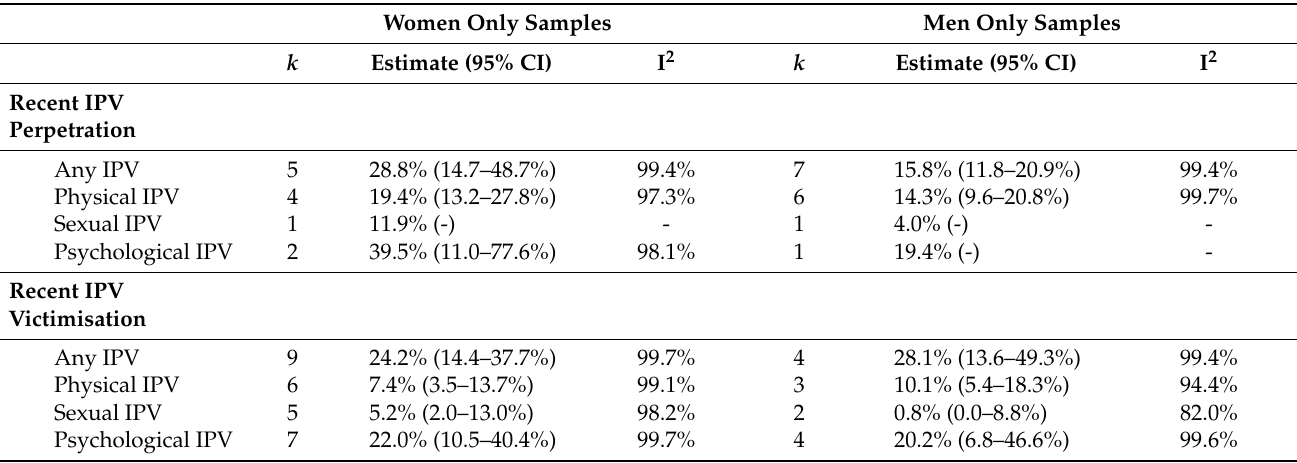
Table 2. Meta-analysis findings reported by gender and IPV